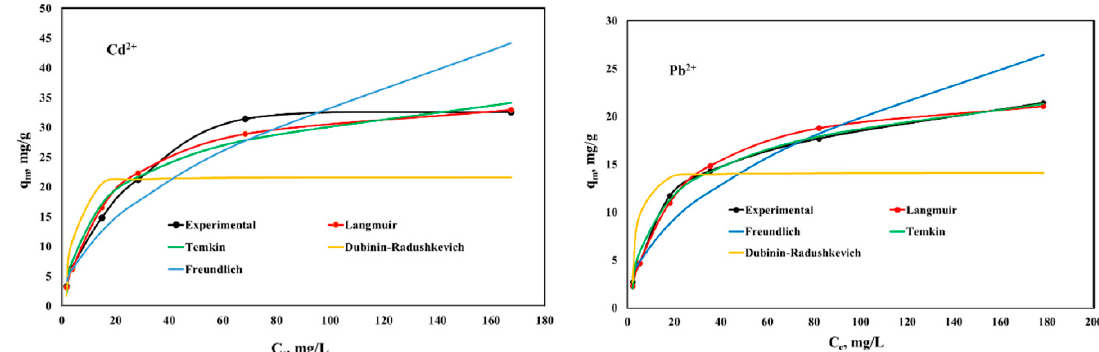
Figure 7. Equilibrium isotherms of Cd 2+ and Pb 2+ adsorption onto CaCEPPA.